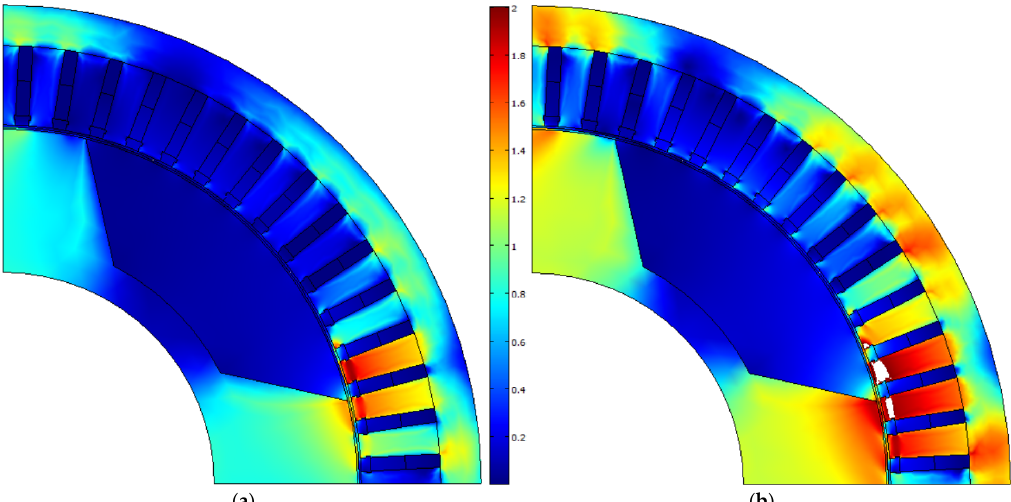
Figure 9. The cross-section of the initial design of the synchronous homopolar motor and the magnitude plot of flux density (T); white areas mark the extreme saturation level (>2 T). ( a ) Operating point 1; ( b ) operating point 4.